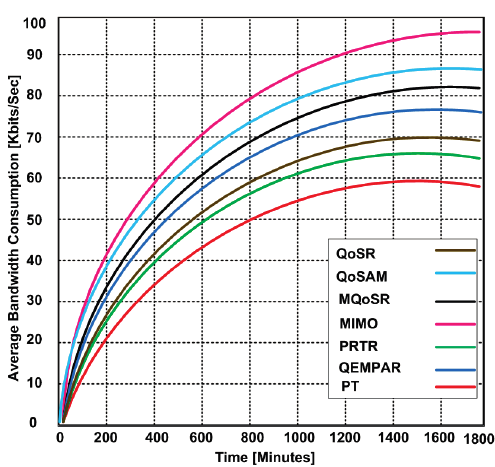
Figure 12. Number of miss deadlines vs. number of set